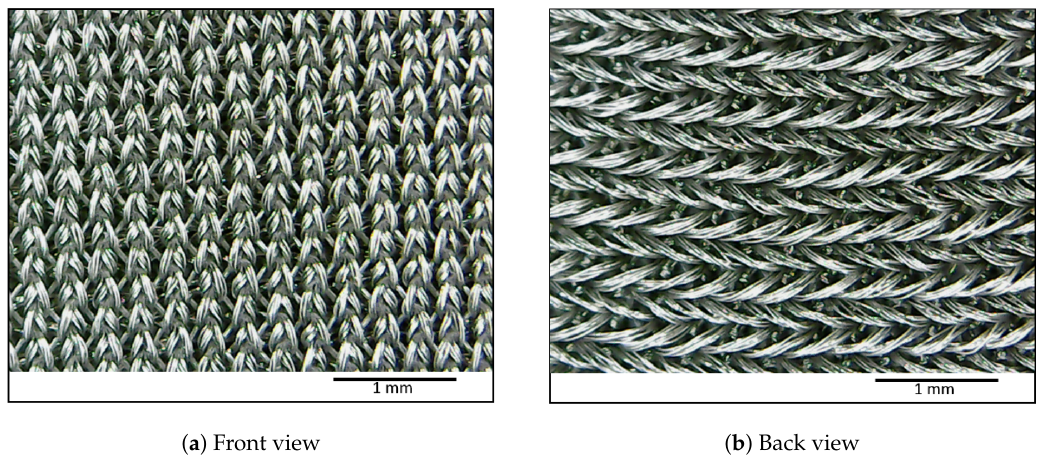
Figure 2. Tightening of front side threads and relaxation of back side threads of the fabric under the horizontal stretch.